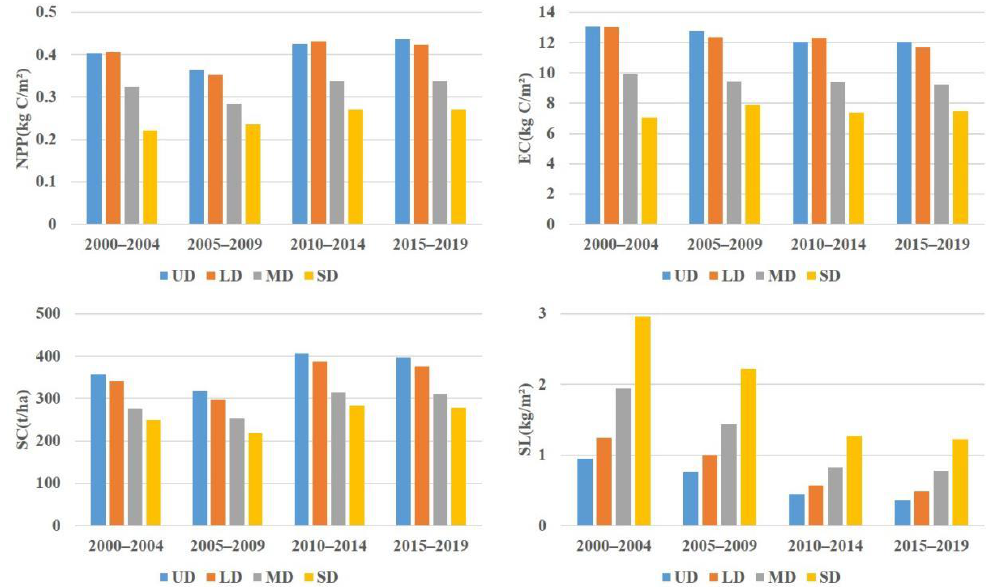
Figure 5. Comparison of ecosystem services of different grassland degradation degrees in the study area, from 2000 to 2019. UD, undegraded grassland; LD, lightly degraded grassland; MD, moderately degraded grassland; SD, severely degraded grassland; NPP, net primary production (kg C/m 2 ); EC, ecosystem carbon (kg C/m 2 ); SC, soil conservation (t/ha); SL, soil loss by wind (kg/m 2 ).